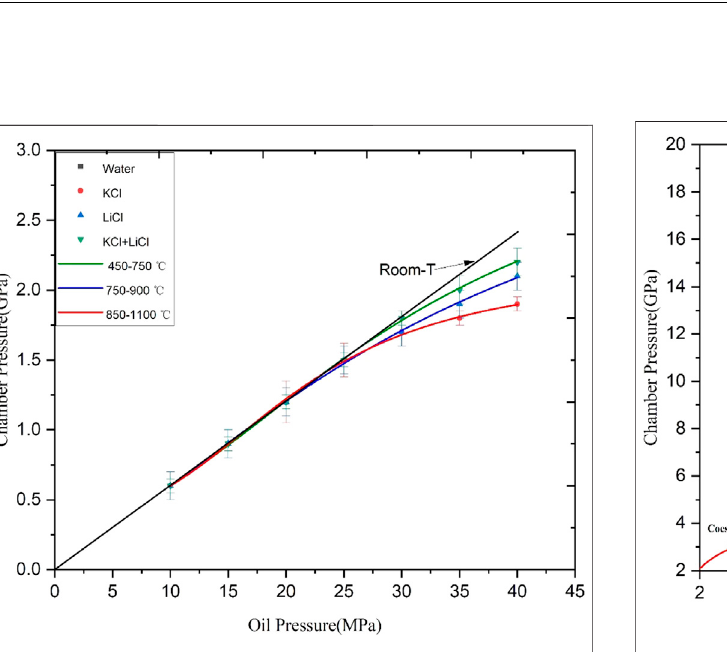
FIGURE 3 | Pressure calibration for the fi rst-stage anvil of the DS 6 × 1400 t 6 – 8 large volume press assembly.